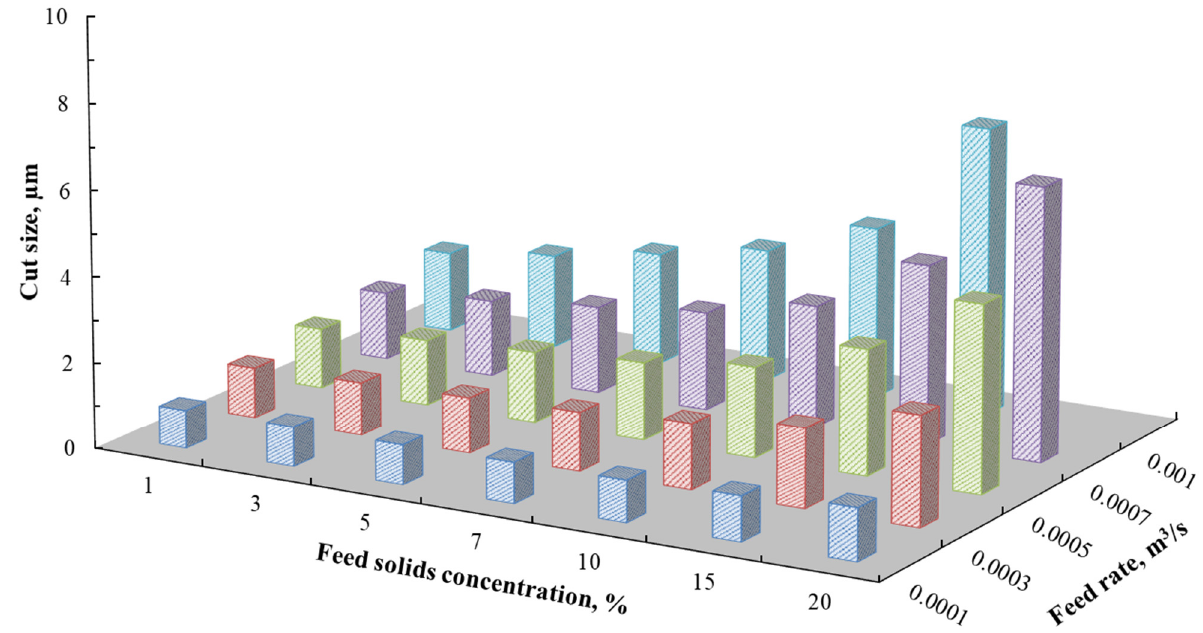
Figure 11. Cut sizes of the SBC at various feed flowrates and feed solids concentrations.